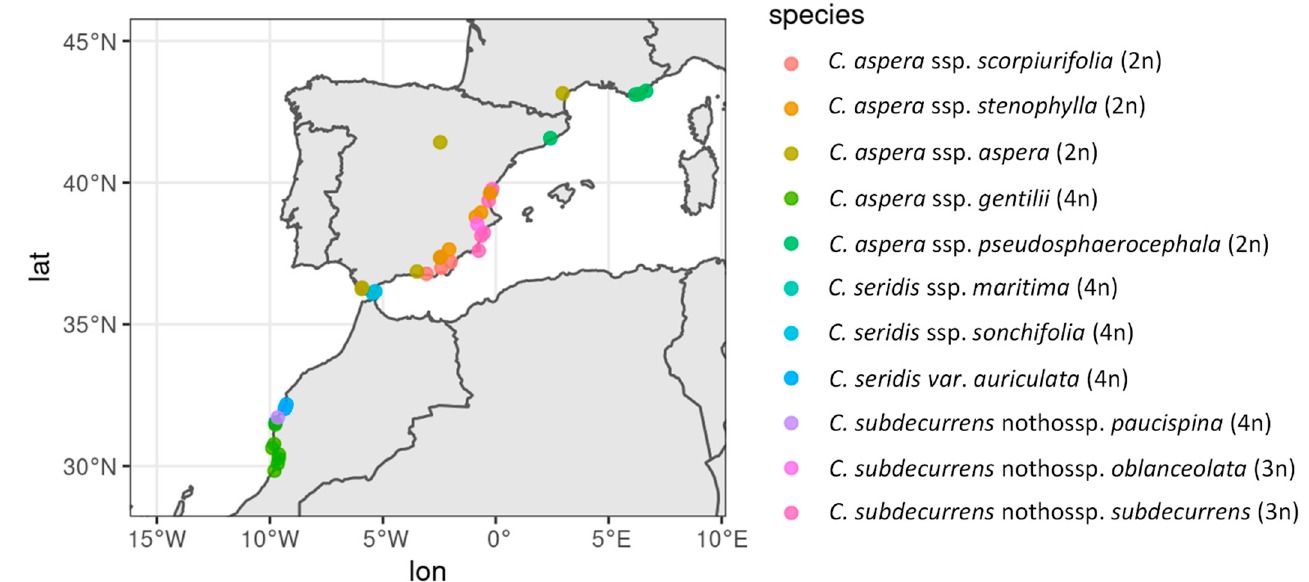
Figure 6. Location of the studied individuals. Map was made with Natural Earth (https://www.nat-